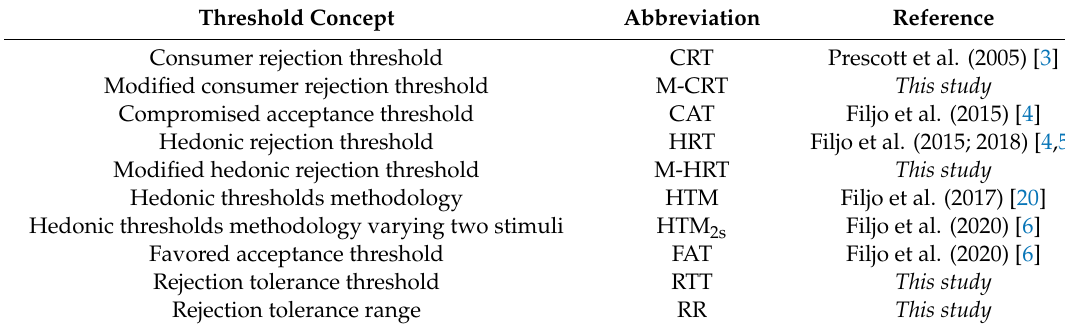
Table 1. Rejection-type threshold